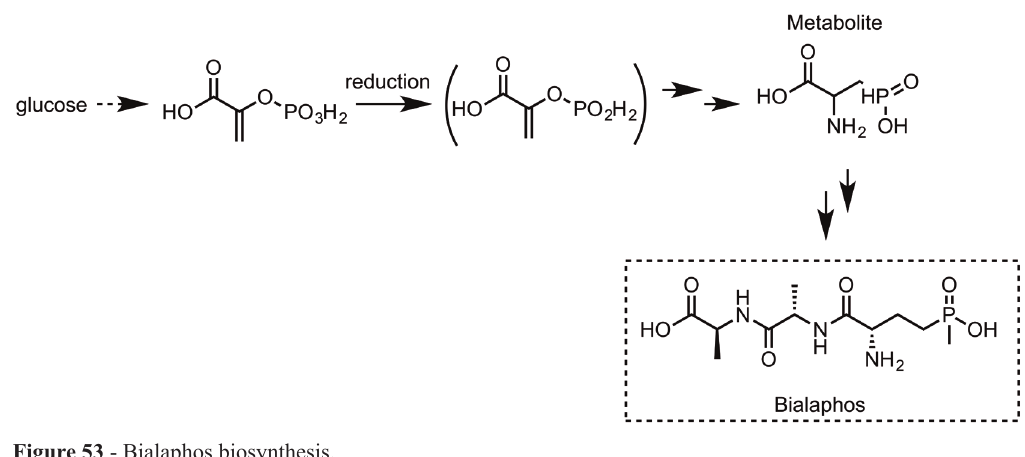
Figure 53 - Bialaphos biosynthesis.